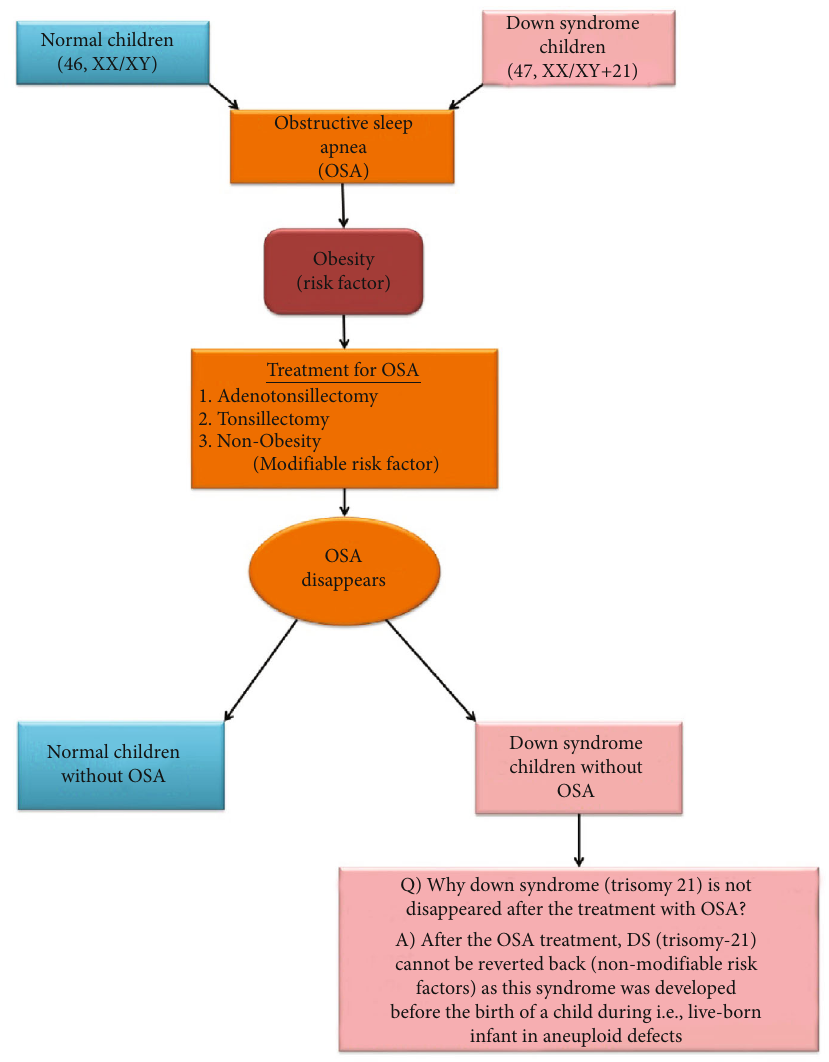
Figure 4: Diagrammatic representation of development of OSA and its